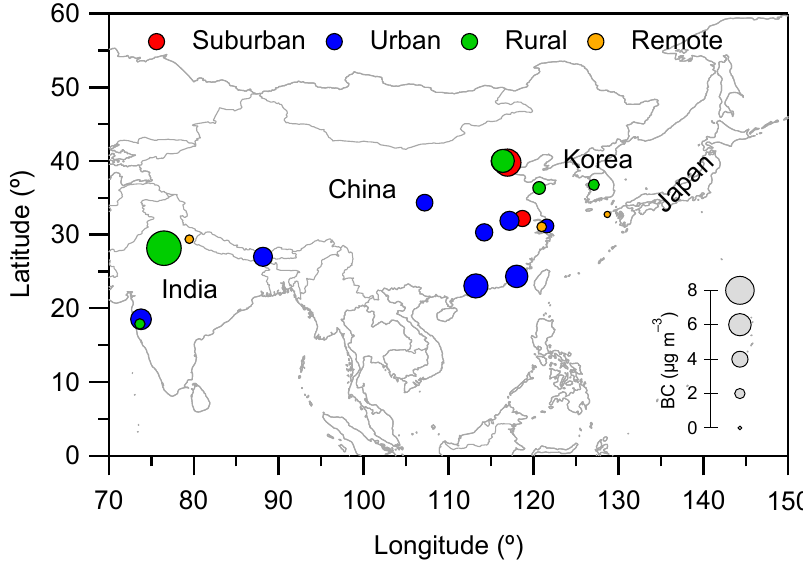
Figure 2. A summary of annual mean values of BC ( μ g m − 3 ) obtained from the present study and previous long-term measurements in East Asia. The colors of the solid circles represent different types of sampling sites, including urban, suburban, rural, and remove, and the size of the data points refers to the mass concentration of BC. More descriptions of those observations are given in Table S1.